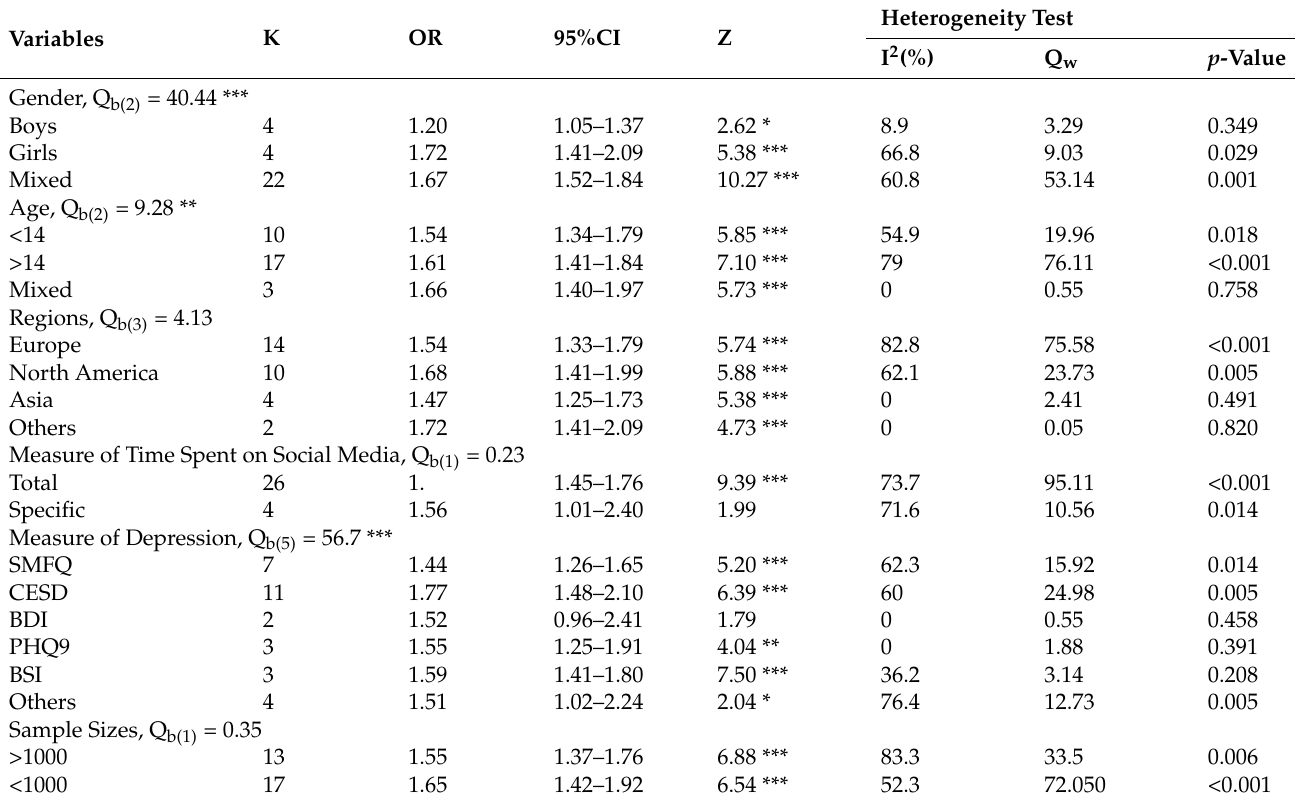
Table 2. Moderation analyses for time spent on social media–depression risk